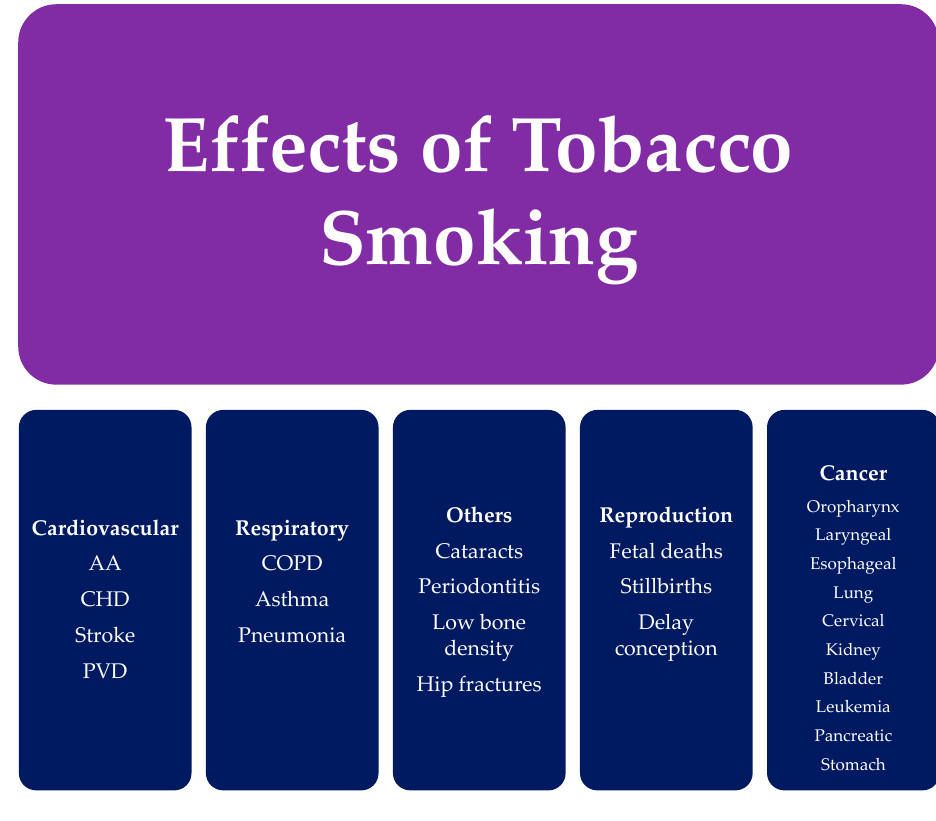
Figure 2. Effects of tobacco smoking [25]. (AA) Aortic aneurysm; (CHD) Coronary heart disease; (PVD) Peripheral Vascular Disease; (COPD) Chronic obstruction pulmonary disease.